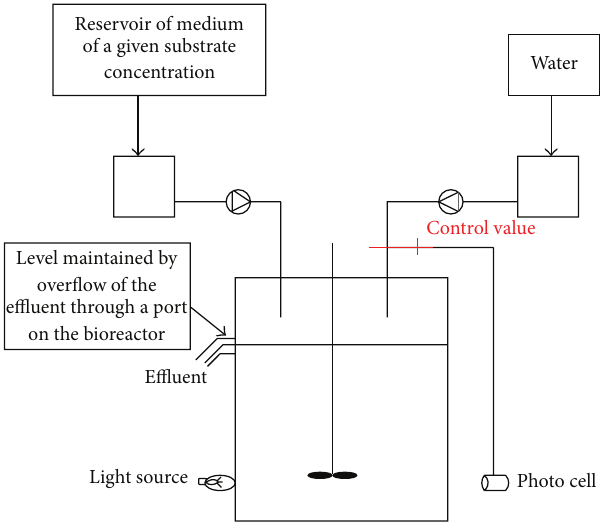
Figure 1: Schematic diagram of microorganism culture system with feedback